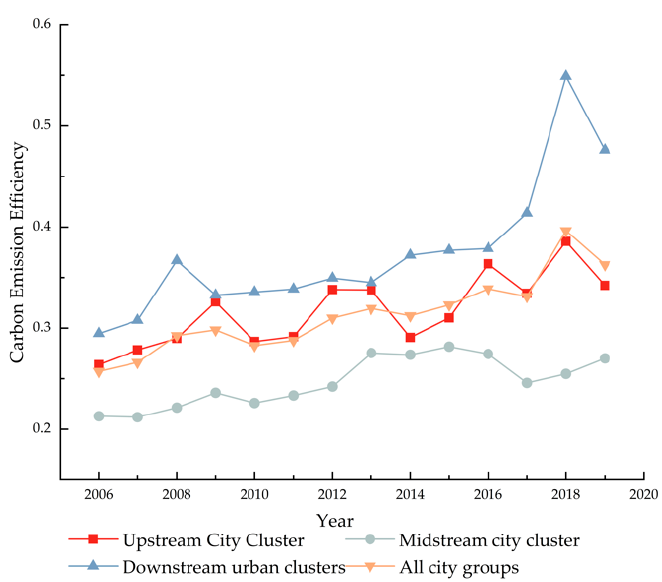
Figure 3. Changes in carbon emission efficiency of upstream and downstream urban agglomera- tions.